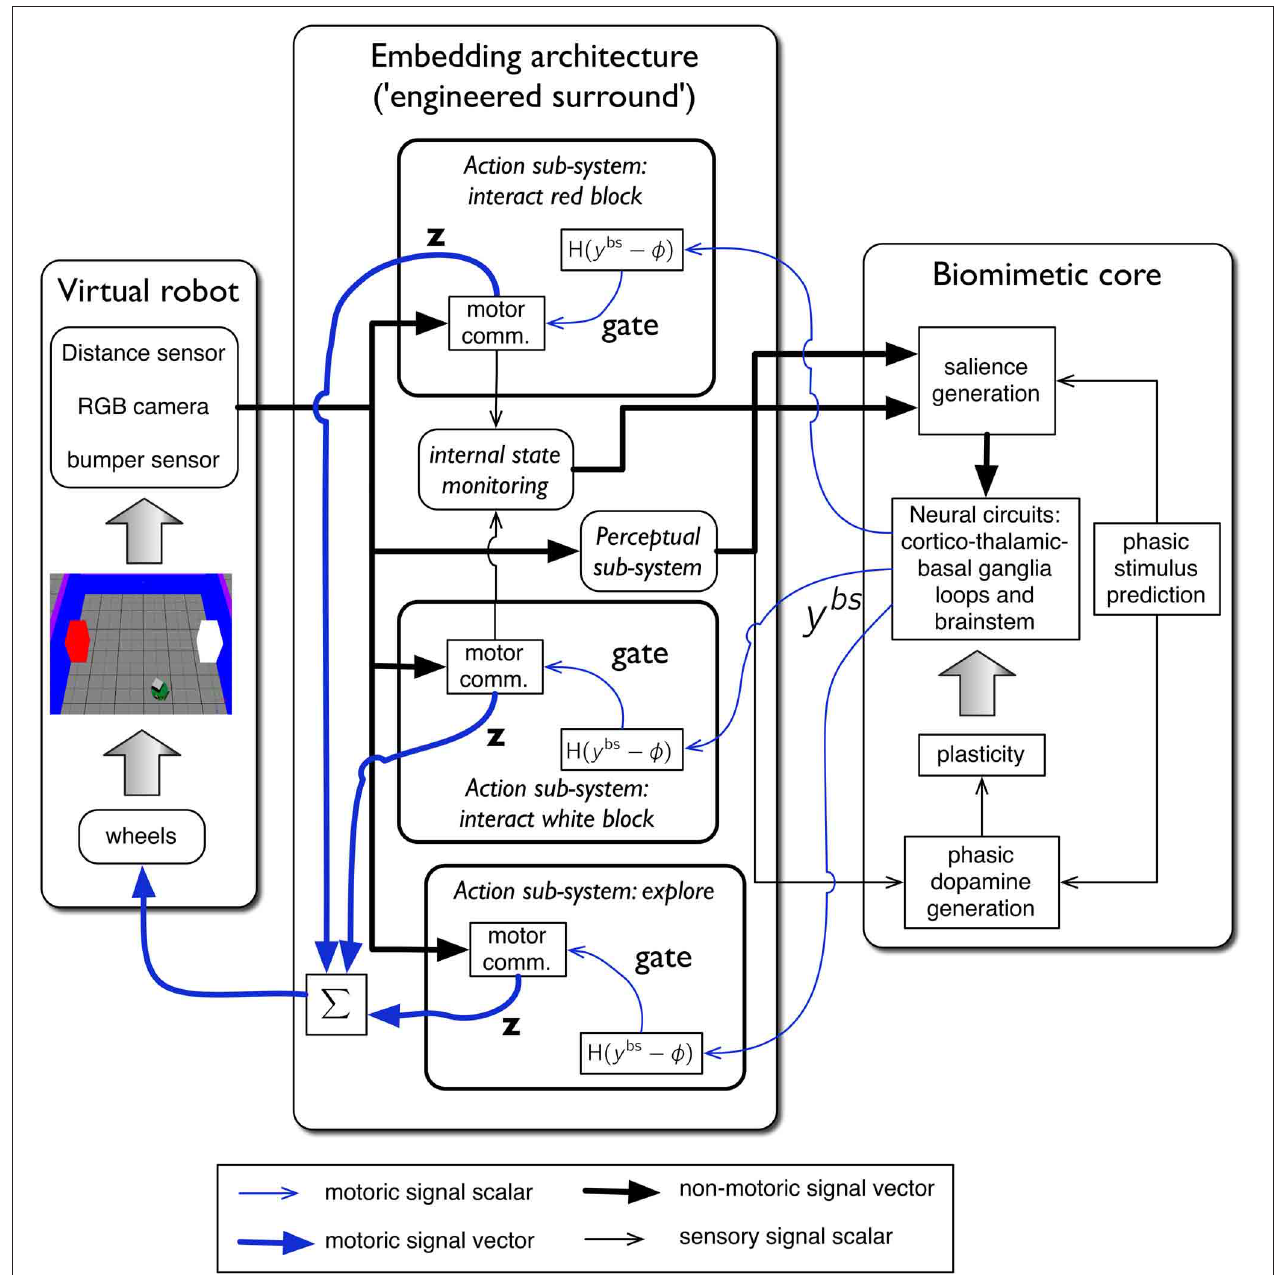
FIGURE 4 | The virtual robot control architecture, and its interaction with the robot and environment. The virtual Khepera robot is endowed a range of sensors and the motor output is locomotion via a pair of wheels. The architecture is split into embedding, and biomimetic core, components. The embedding architecture contains three action-subsystems: two for approaching-and-bumping into each of the red and white blocks (“interact red block,” “interact white block”), and one (“explore”) for randomly roaming the